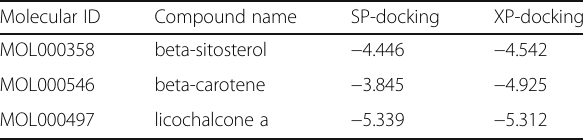
Table 5 SP- and XP-Docking score of three compounds Molecular